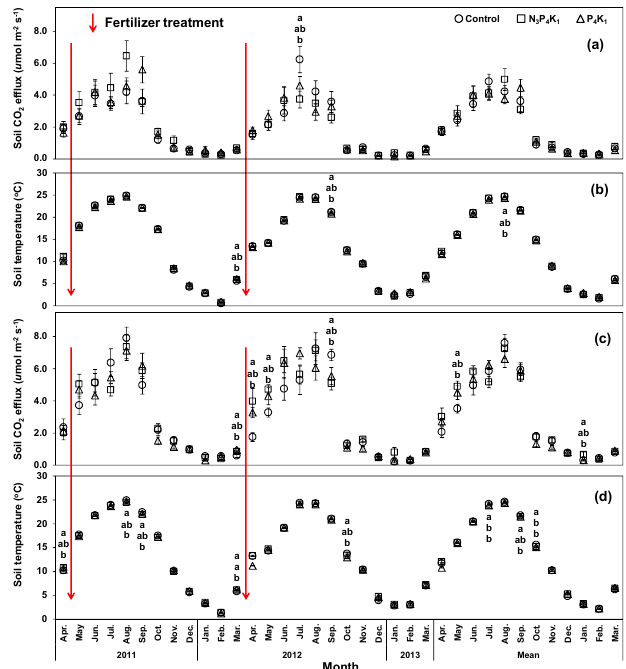
Figure 2. Monthly variation of Rh rates ( a ) and soil temperature ( b ) or Rs rates ( c ) and soil temperature ( d ) for fertilizer and control treatments in red pine stands. Vertical bars represent standard errors ( n = 12). Different letters at each month indicate a significant difference among treatments at p < 0.05.